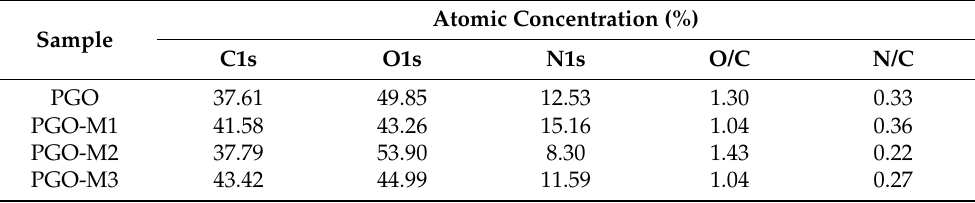
Figure 6. XPS survey scans of PGO, PGO-M1, PGO-M2, and PGO-M3 nanofibers. Table 1. Atomic concentrations (%) of functionalized nanofibers based on deconvolution of XPS spectra.